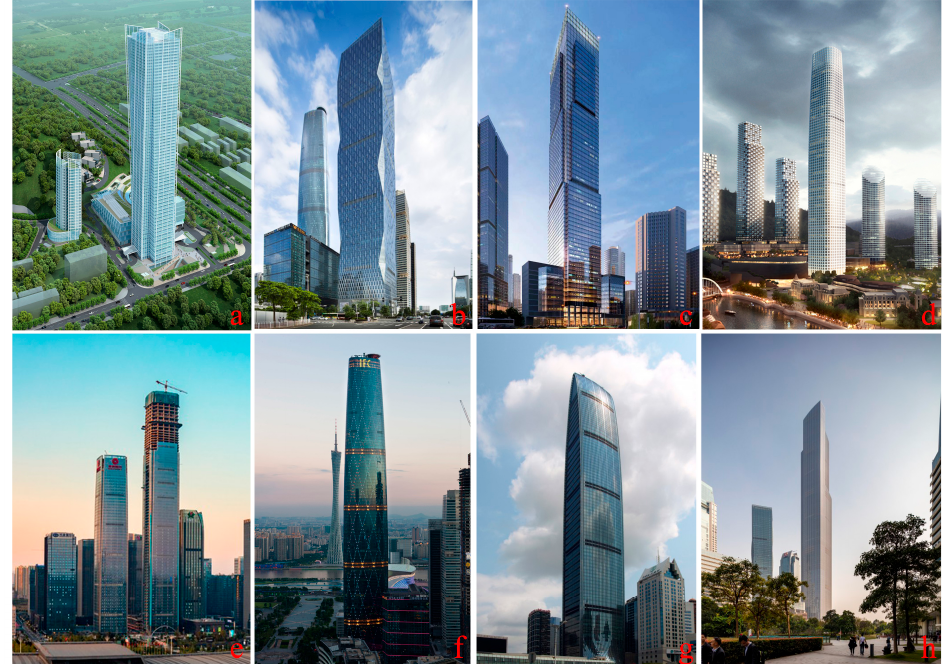
Figure 8. The eight MUHR buildings investigated in this study. ( a ) Dongguan International; ( b ) Guangzhou Fuli Yingkai; ( c ) Guangxi Jiuzhou; ( d ) Guiyang World Trade Center; ( e ) Guiyang International Financial Center; ( f ) Guangzhou International Financial Center; ( g ) Kingkey 100 Building; ( h ) Guangzhou Chow Tai Fook Financial Center